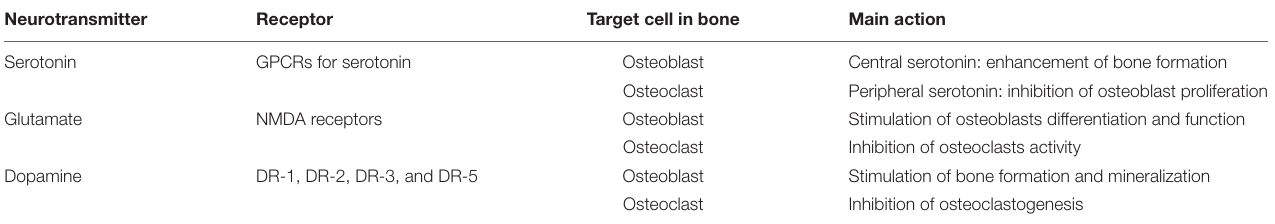
TABLE 4 | Brain to bone communication: neurotransmitters.